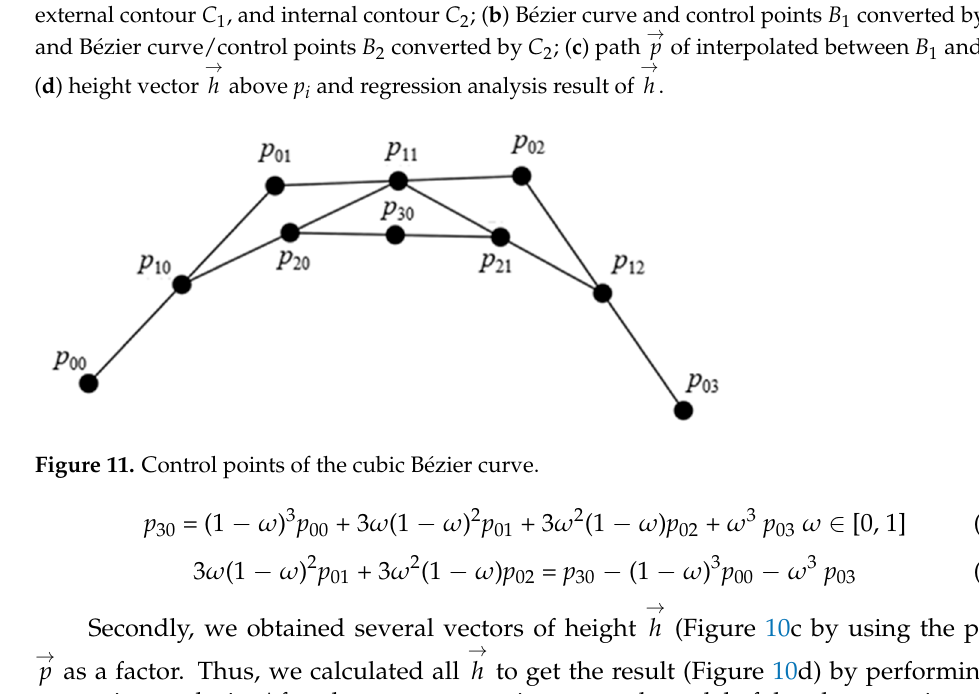
  of interpolated between B 1 and → of interpolated between B 1 and p of interpolated between B 1 and B 2 ;  .  → . h .